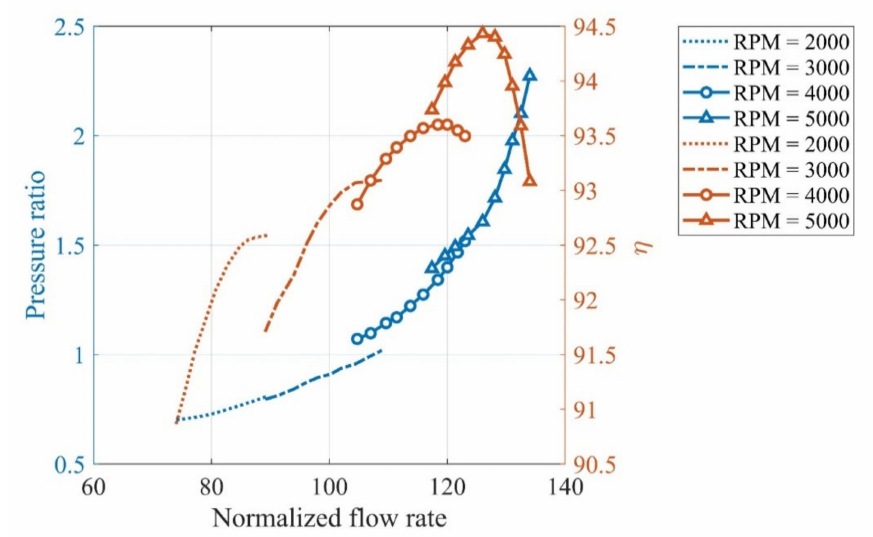
Figure 19. O ff -design maps for the optimized turbine